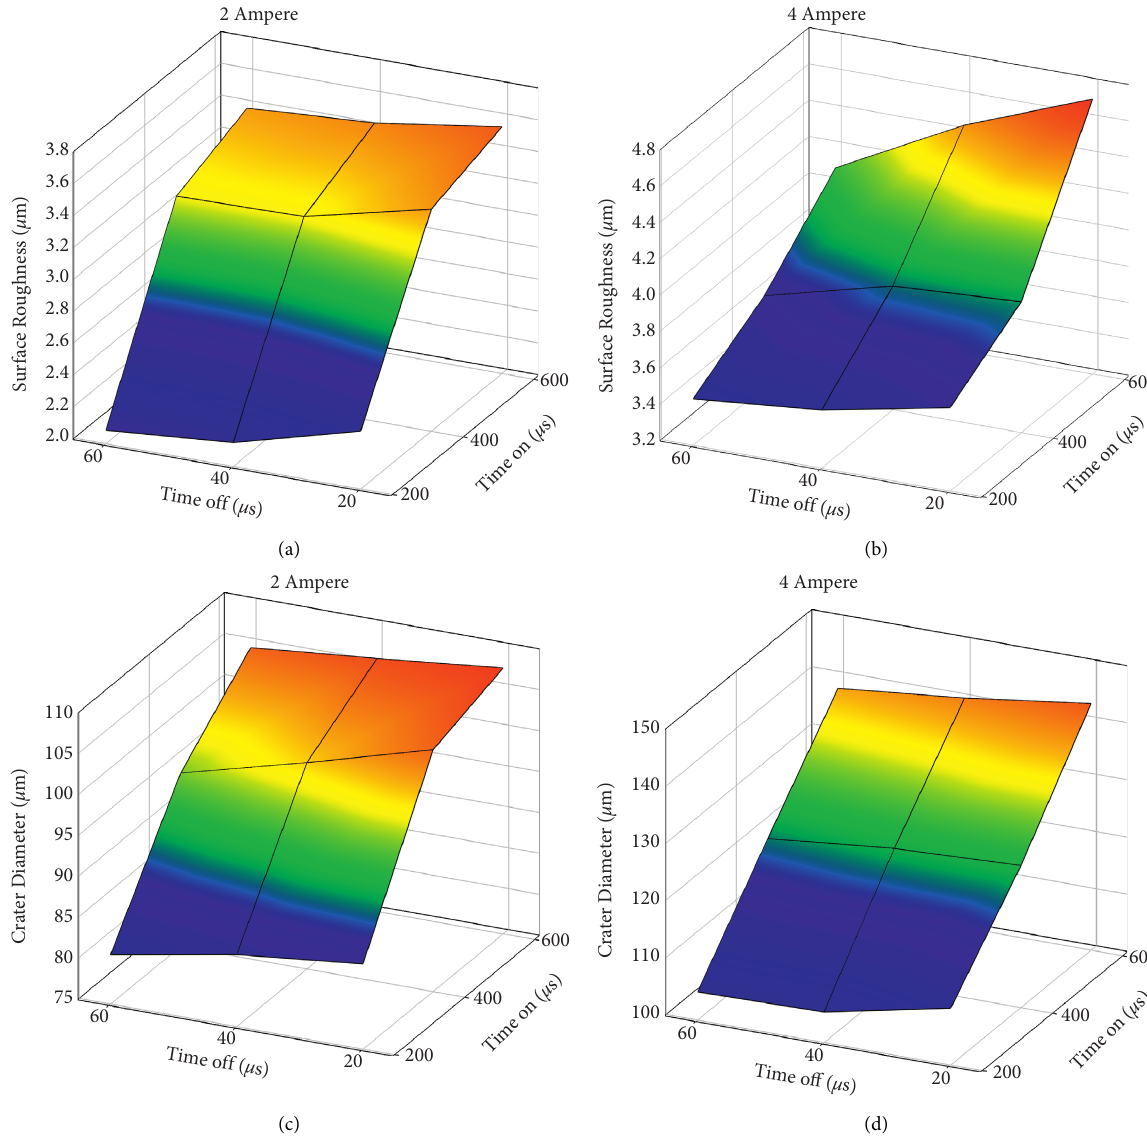
Figure 6: Effect of pulse time-on and time-off on surface roughness and crater diameters at 2 (a, c) and 4 (b, d)